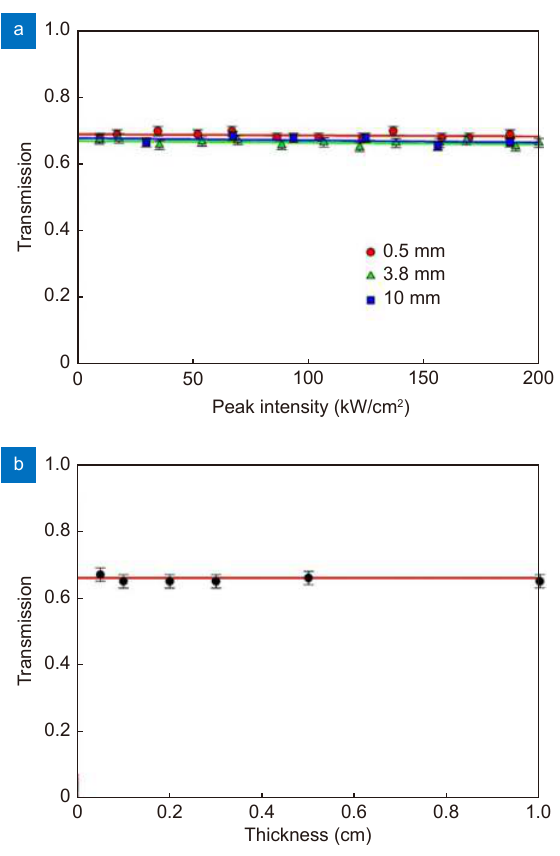
Fig. 4 | ( a ) Transmission curves with thickness of ZnSe and intensity with nanosecond exposure. ( b ) Transmission with sample thickness at intensity of 0.02 GW cm –2 with 200 fs exposure at 775 nm.